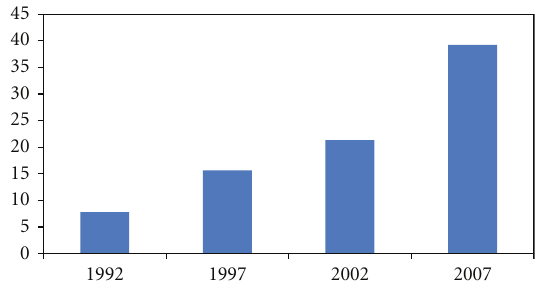
Figure 2: China’s embodied energy use in infrastructure investment in absolute term (million tons of standard coal).